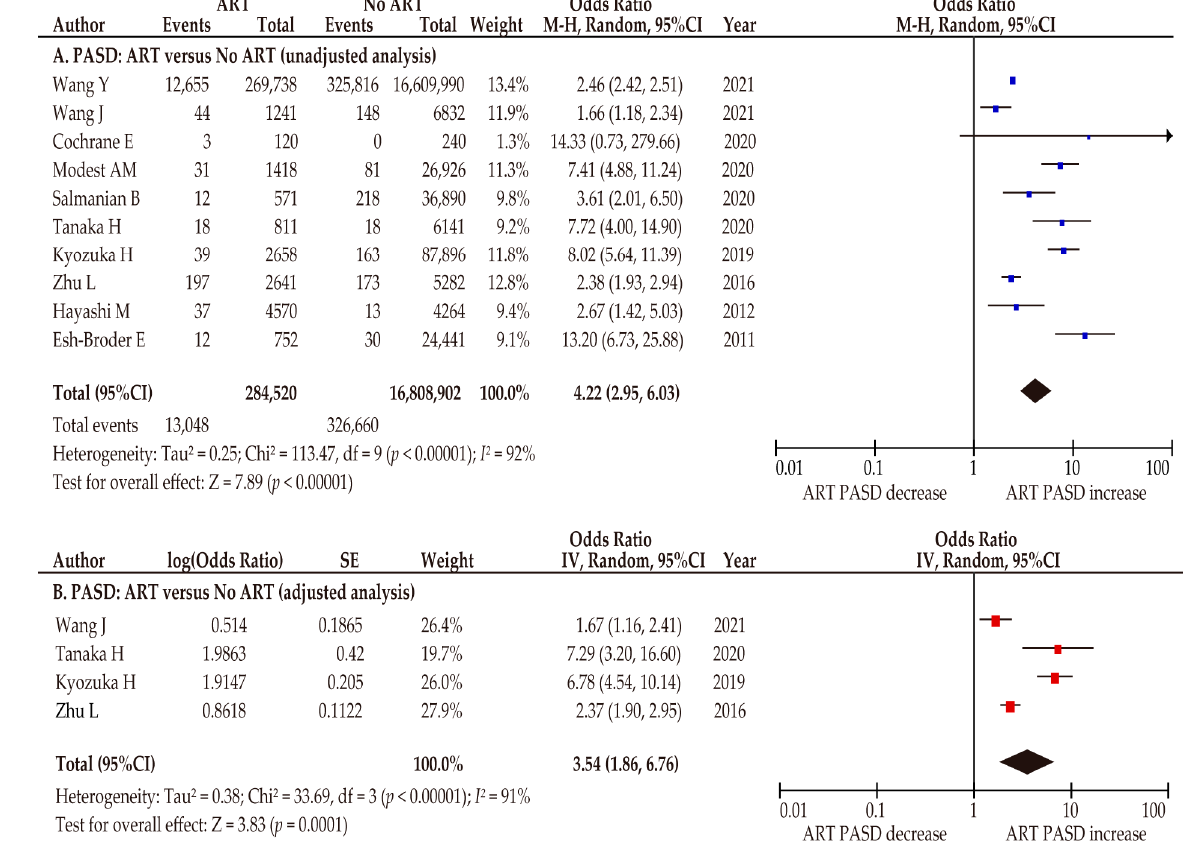
Figure 5. Effect of assisted reproductive technology on the incidence of placenta accreta spectrum. The pooled odds ratios (ORs) for the ( A ) unadjusted analysis of PASD and ( B ) adjusted analysis of PASD for women who conceived using ART and women who conceived without ART. Forest plots were ordered within the stratum by relative weight (%) and the publication year of the study. Considerable heterogeneity was observed during the unadjusted analysis ( A : I 2 = 92%) and the adjusted analysis ( B : I 2 = 91%). Some values might be slightly different from the original values, as calculations were performed using RevMan ver. 5.4.1. Abbreviations: ART, assisted reproductive technology; OR, odds ratio; CI, confidence interval; SE, standard error; PASD, placenta accreta spectrum disorder.